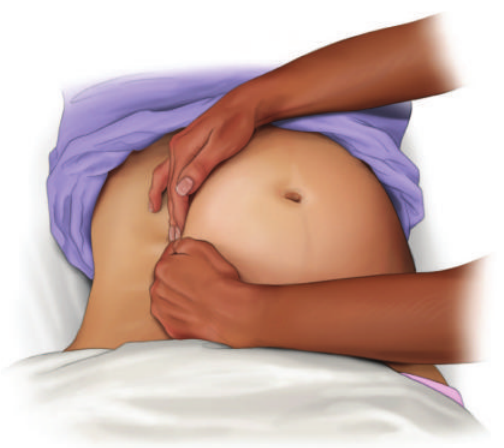
Figure 2: Left uterine displacement with 2-handed technique [3].